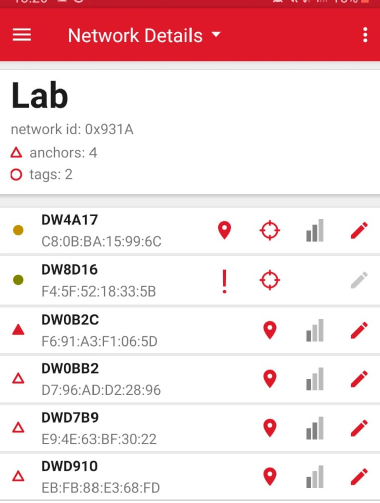
Figure 1. Lab RTLS network configuration using Android application.